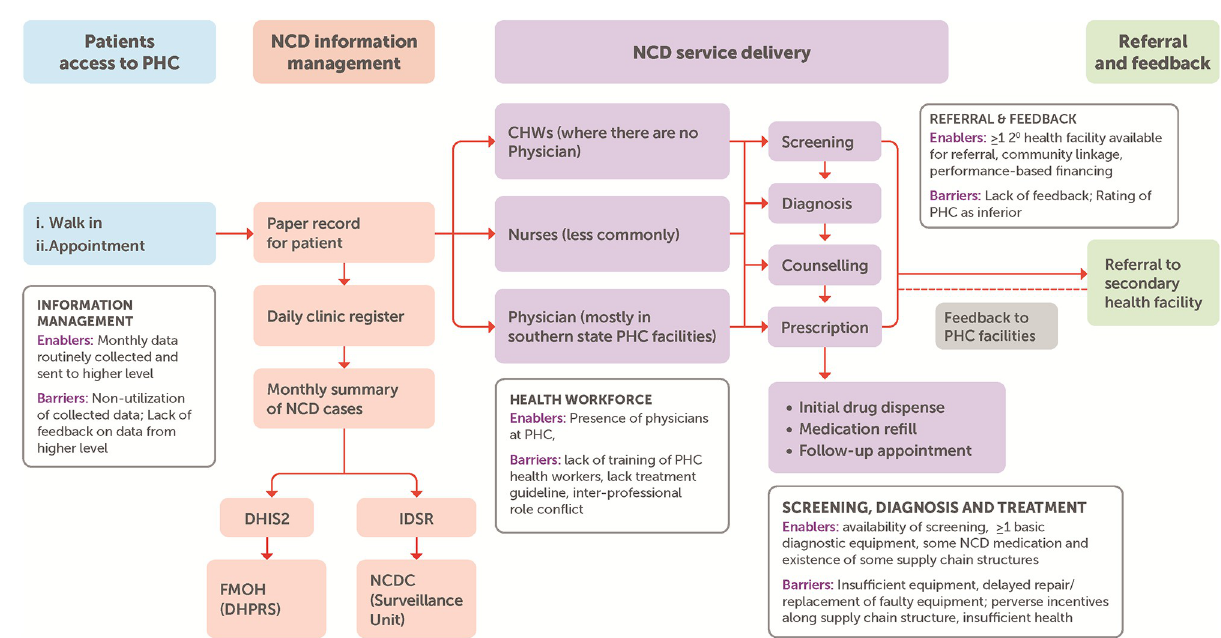
Fig 2. Patient flow for NCD service delivery at the PHC level, with enablers and barriers along the pathway.